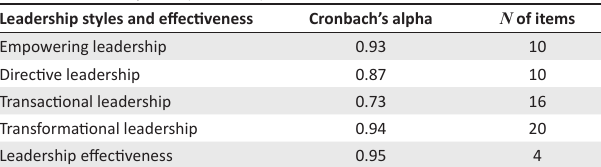
TABLE 6: Model summary, ANOVA, and coefficients for leadership styles predicting leader effectiveness, given the generation of the followers (the observers). Regression